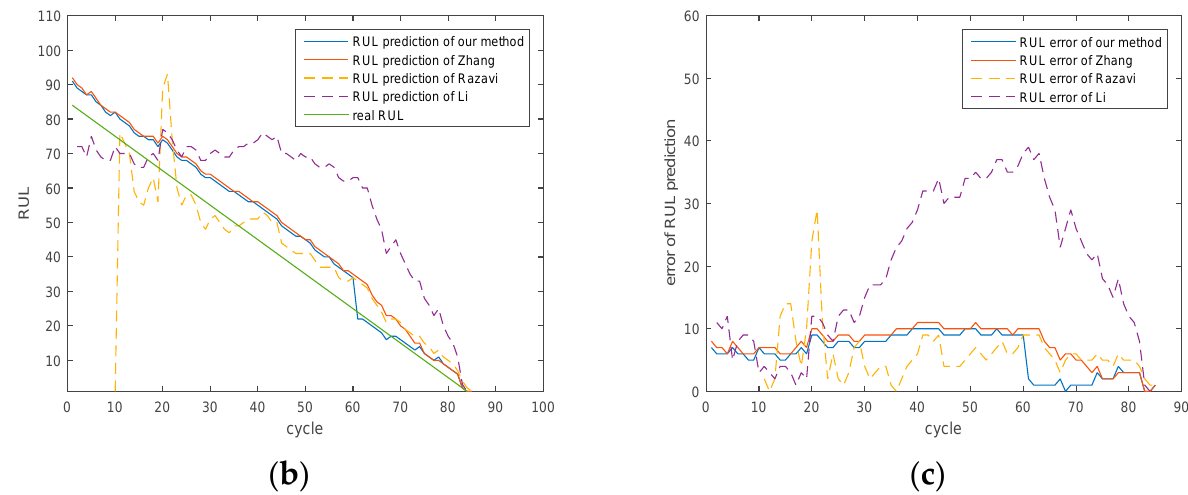
Figure 12. RUL prediction of CS2-35. ( a ) The probability density function (PDF) of RUL obtained by the proposed method; ( b ) RUL at different times; and ( c ) error of RUL prediction at different times.